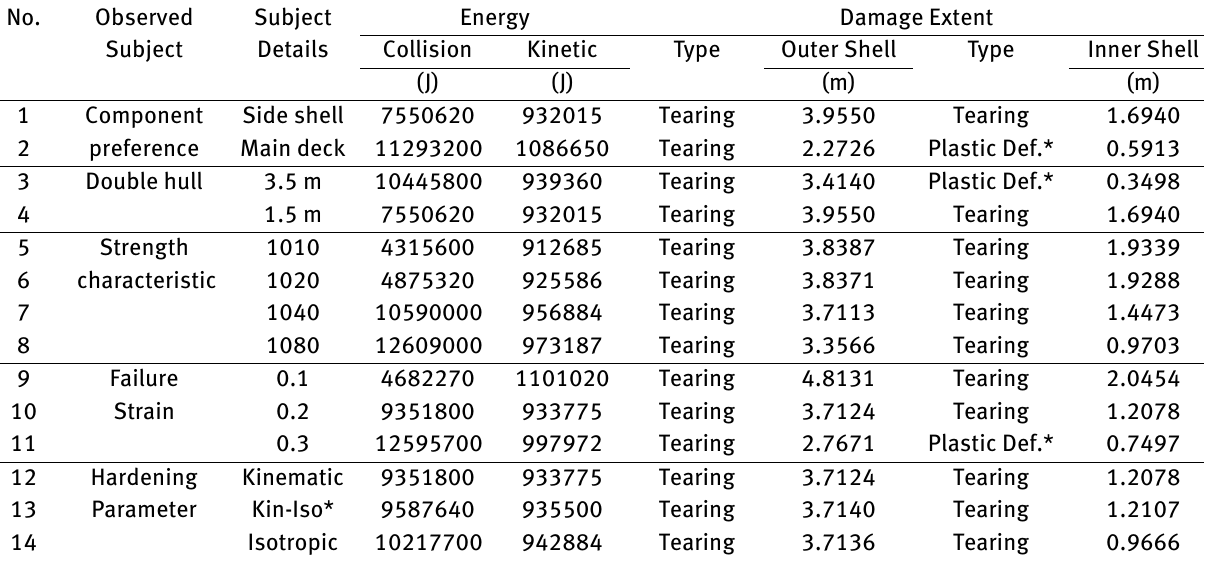
Table 3: Structural results of ship structure according applied parameters.